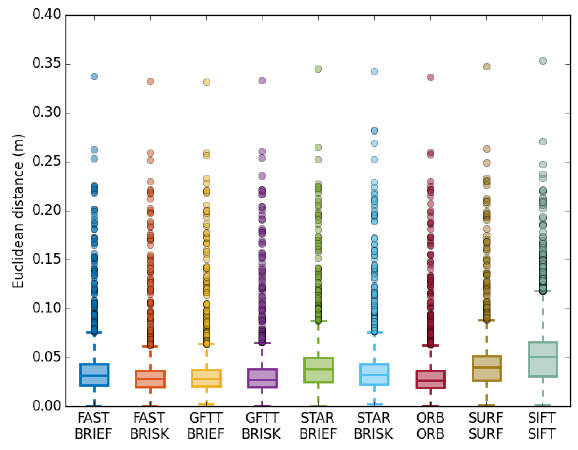
Figure 4. Relative translation error